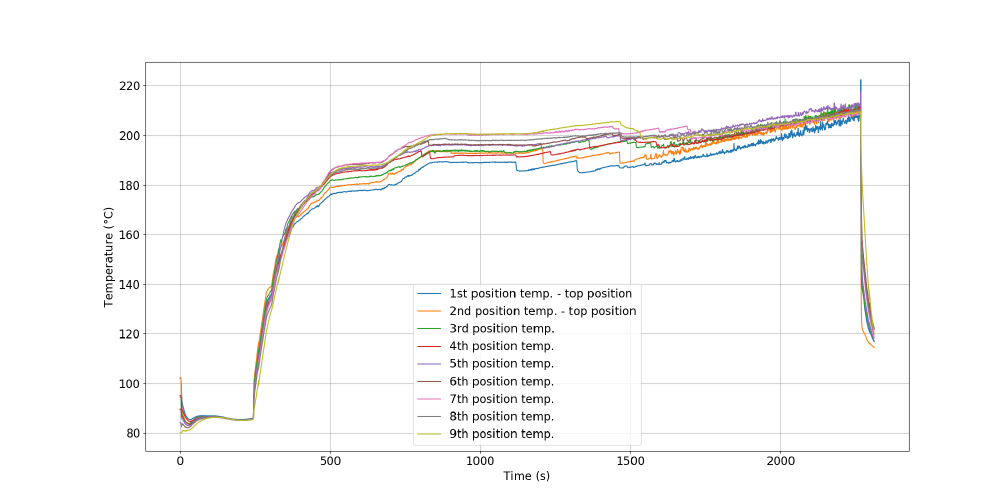
Figure 19. Temperatures during 300 kPa and 600 kg/(m 2 .